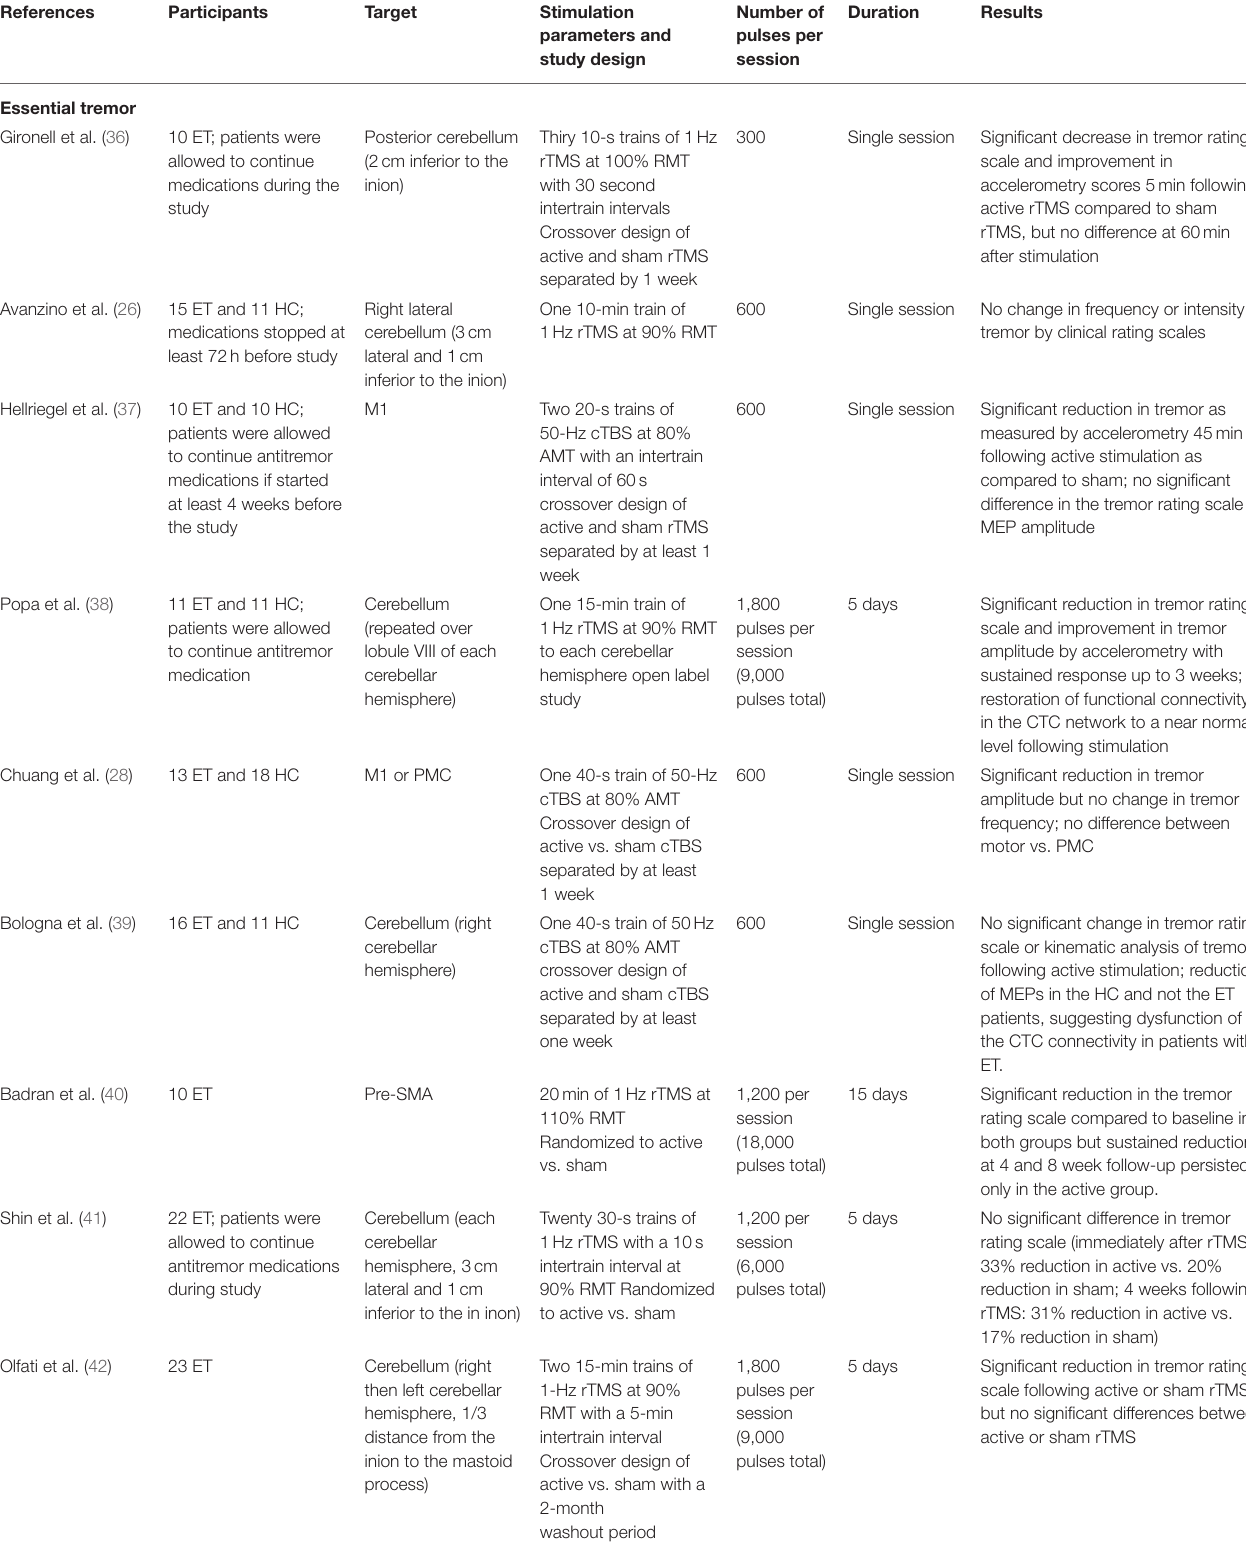
TABLE 2 | rTMS studies for therapeutic use in tremor